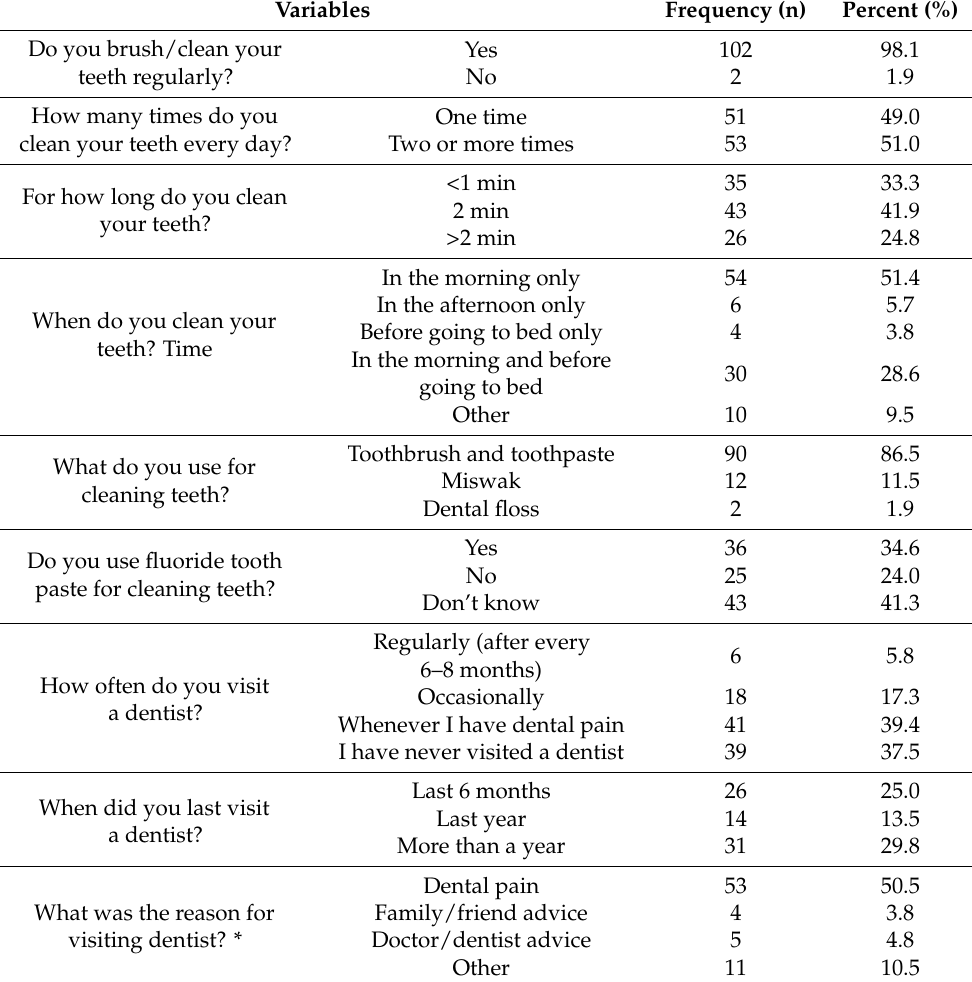
Table 2. Oral hygiene habits of the